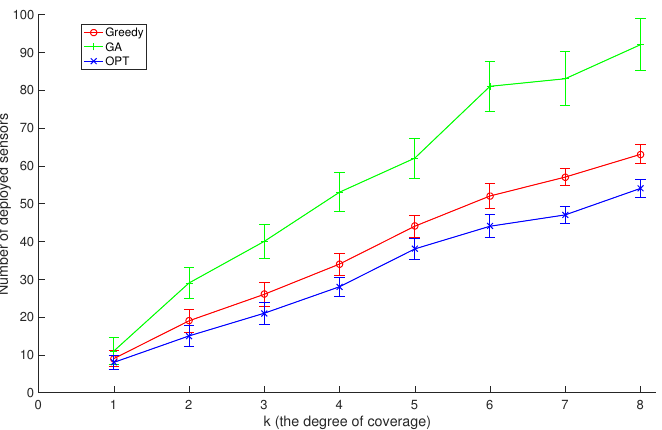
Figure 7. Comparison of the average performance with the standard deviation between GreedyDLDT (Greedy), Genetic Algorithm (GA), and Optimal Algorithm (OPT) for DLDT in response to varying k values.